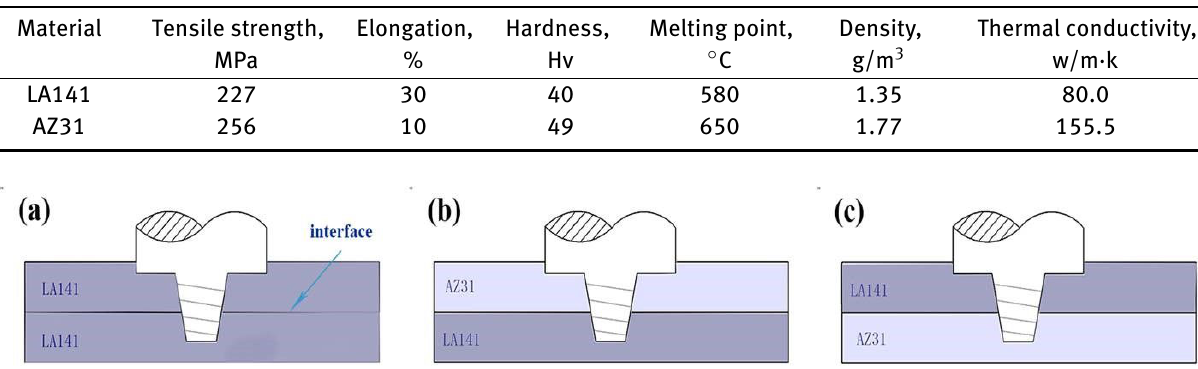
Figure 1: The lap configurations: FSLW of (a) LA141/LA141 (b) AZ31/LA141 and (c) LA141/AZ31.